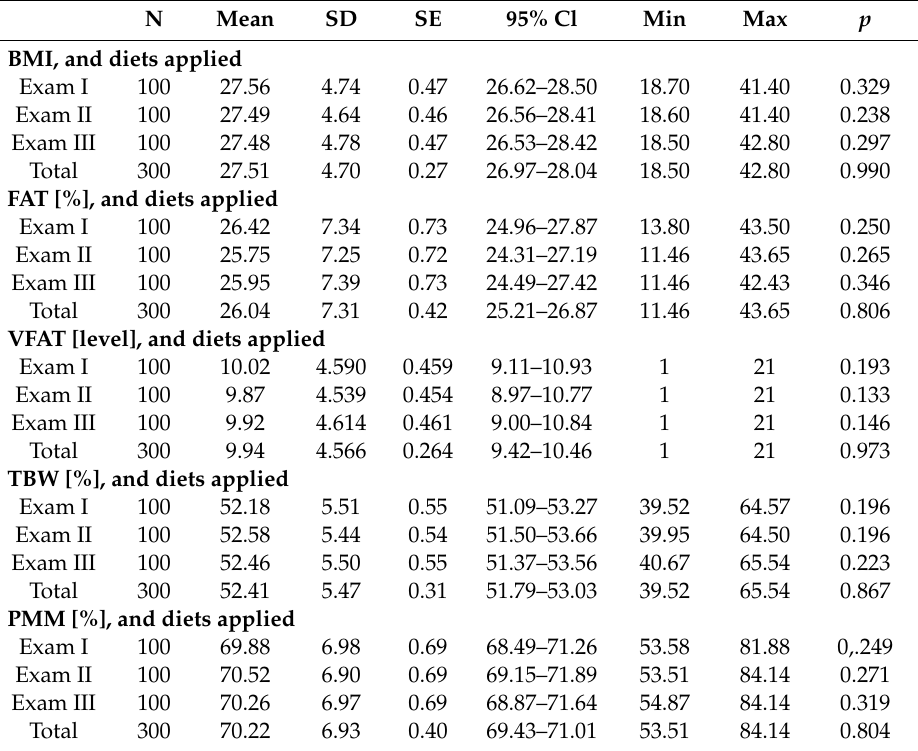
Table 2. Diets and body mass components in examinations I, II, and